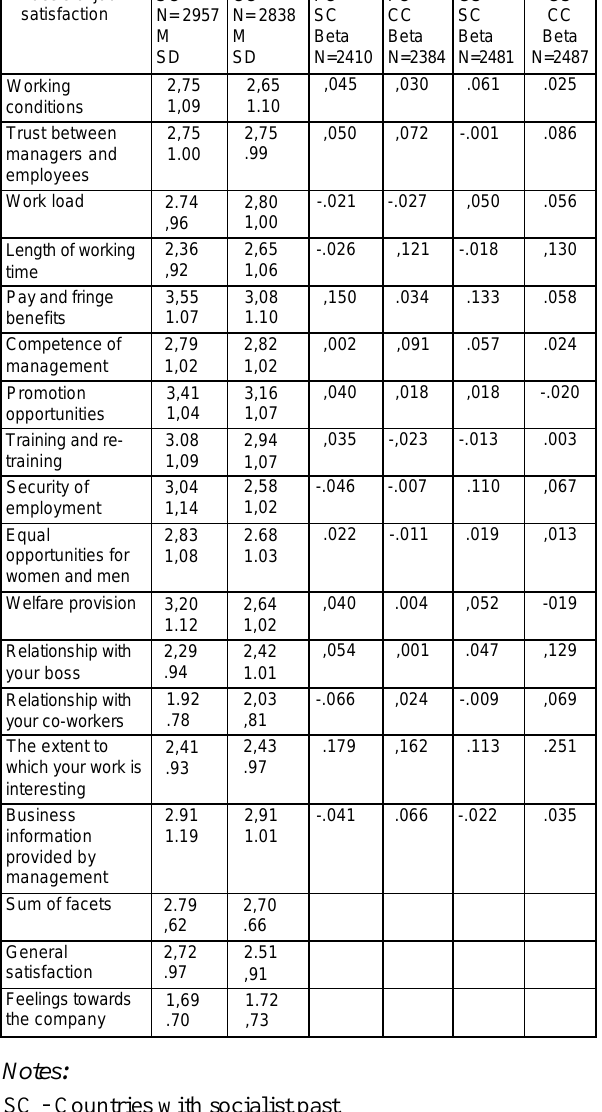
Table 1. Facets of job satisfaction affecting employee feelings toward the organisation they work for and general satisfaction with work life